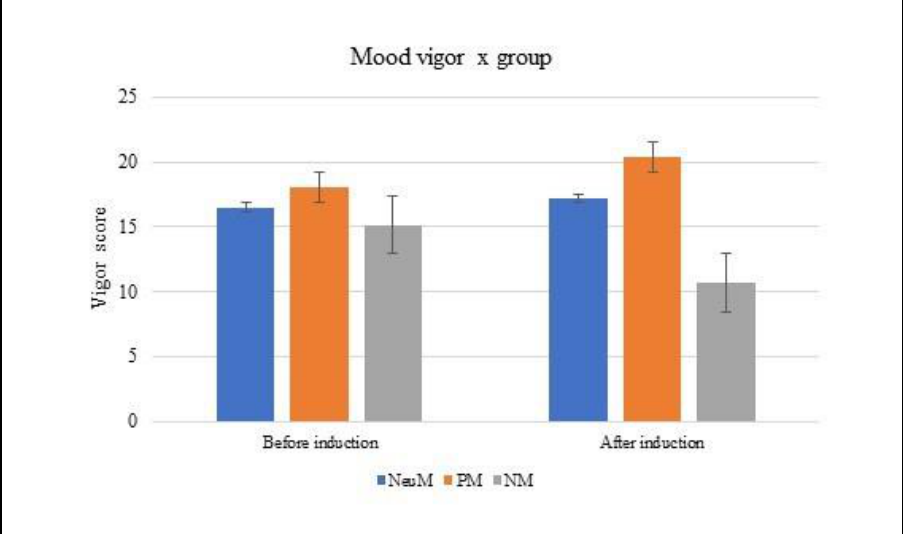
Figure 1. Rating of the ‘vigor’ sub-score of the POMS before and after mood induction, with respect to positive, negative and neutral music groups. The error bars represent the standard errors of the means.